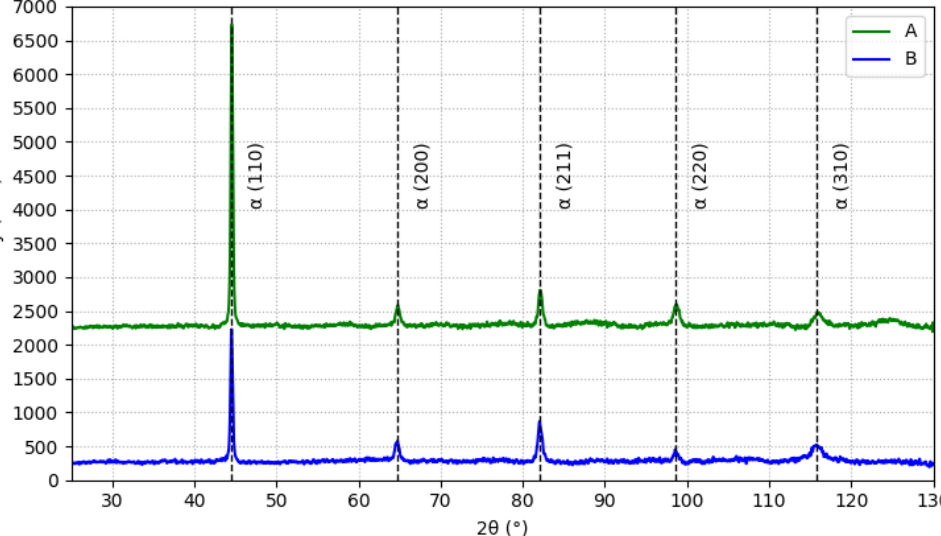
Figure 4. Diffractograms obtained from the XRD analysis of both H13 steels.